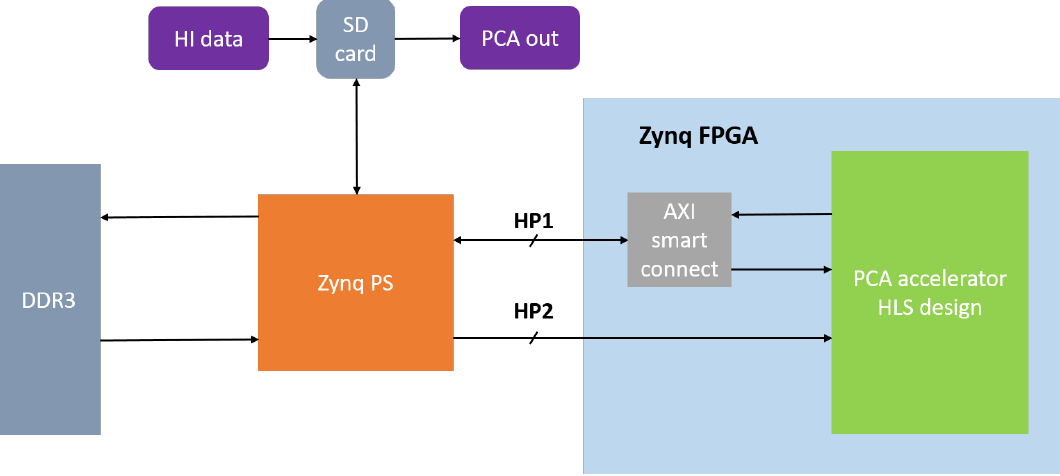
Figure 8. PCA accelerator design in